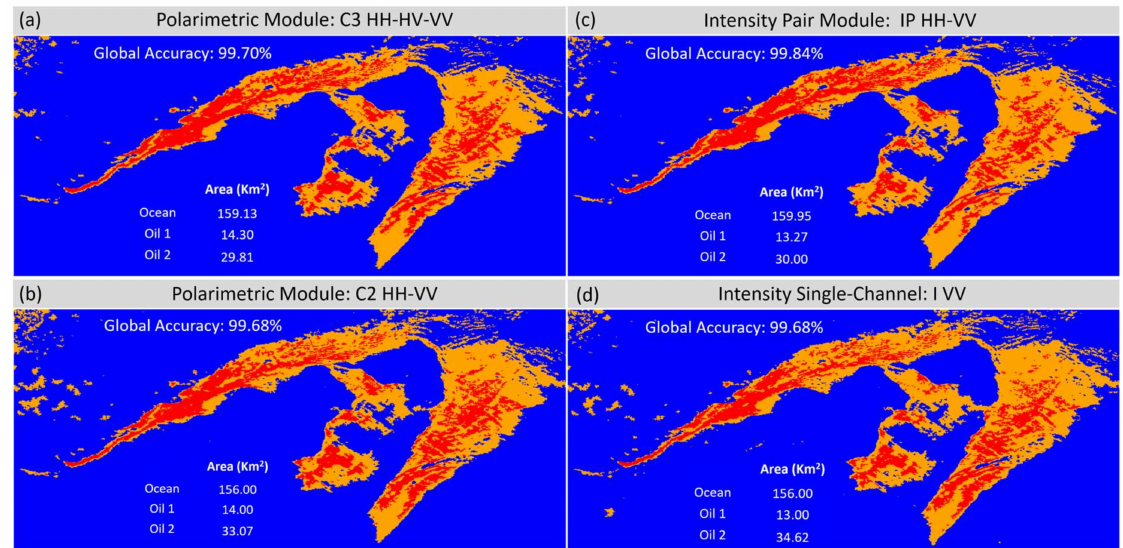
Figure 5. Classification results obtained by the better overall accuracies, all of then indicated as statistically equivalent: ( a ) covariance matrix full-pol (C3: HH-HV-VV): ( b ) covariance matrix dual-pol (C2: HH-VV), ( c ) Intensity Pair (IP: HH-VV), and ( d ) Intensity Single-channel (I: